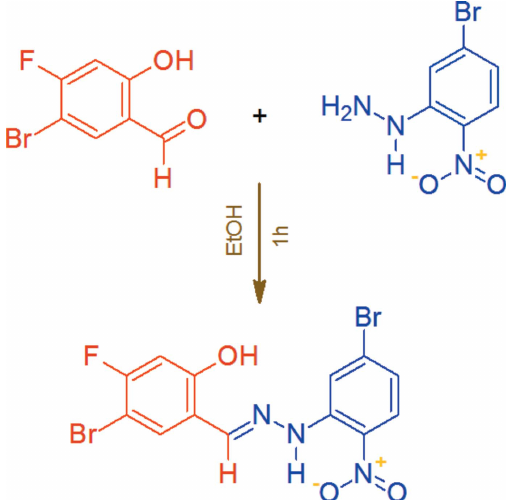
Figure 7 The synthesis of the title